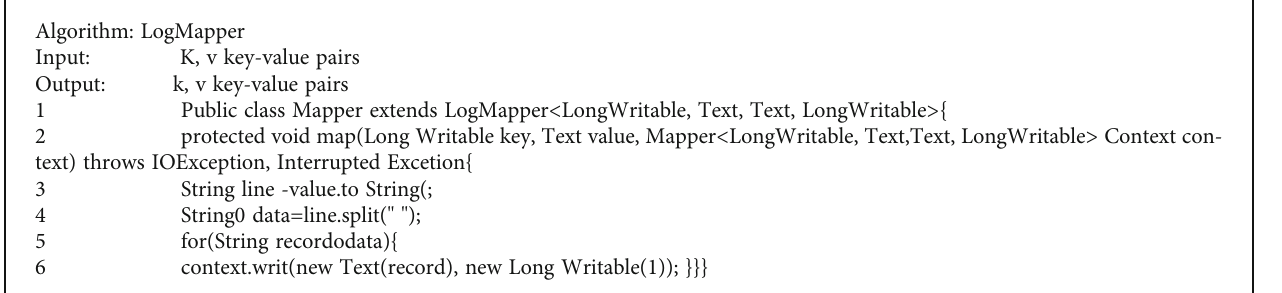
Algorithm 1: Pseudocode for the map